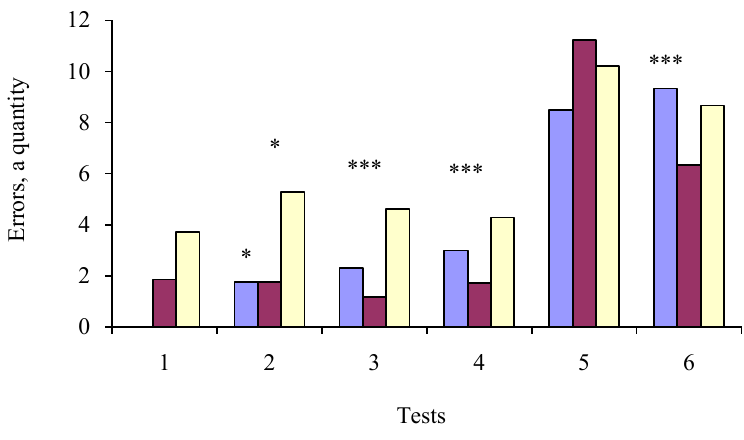
Fig.5. Quantity of errors in fulfillment of tests for determination of latent response time of elite athletes, specializing in speed climbing (n=10),climbing on complexity (n=10) and mountaineers (n=6) 1 - errors at 1 st stage of test “level of functional mobility of nervous processes” in forced rhythm mode, %; 2 – errors at 2 nd stage of test “level of functional mobility of nervous processes” in forced rhythm mode, %; 3 - errors at 3 rd stage of test “level of functional mobility of nervous processes” in forced rhythm mode, %; 4 - errors at 4 th stage of test “level of functional mobility of nervous processes” in forced rhythm mode, %; 5 - errors at 5 th stage of test “level of functional mobility of nervous processes” in forced rhythm mode, %; 6 – errors in test “strength of nervous processes”,